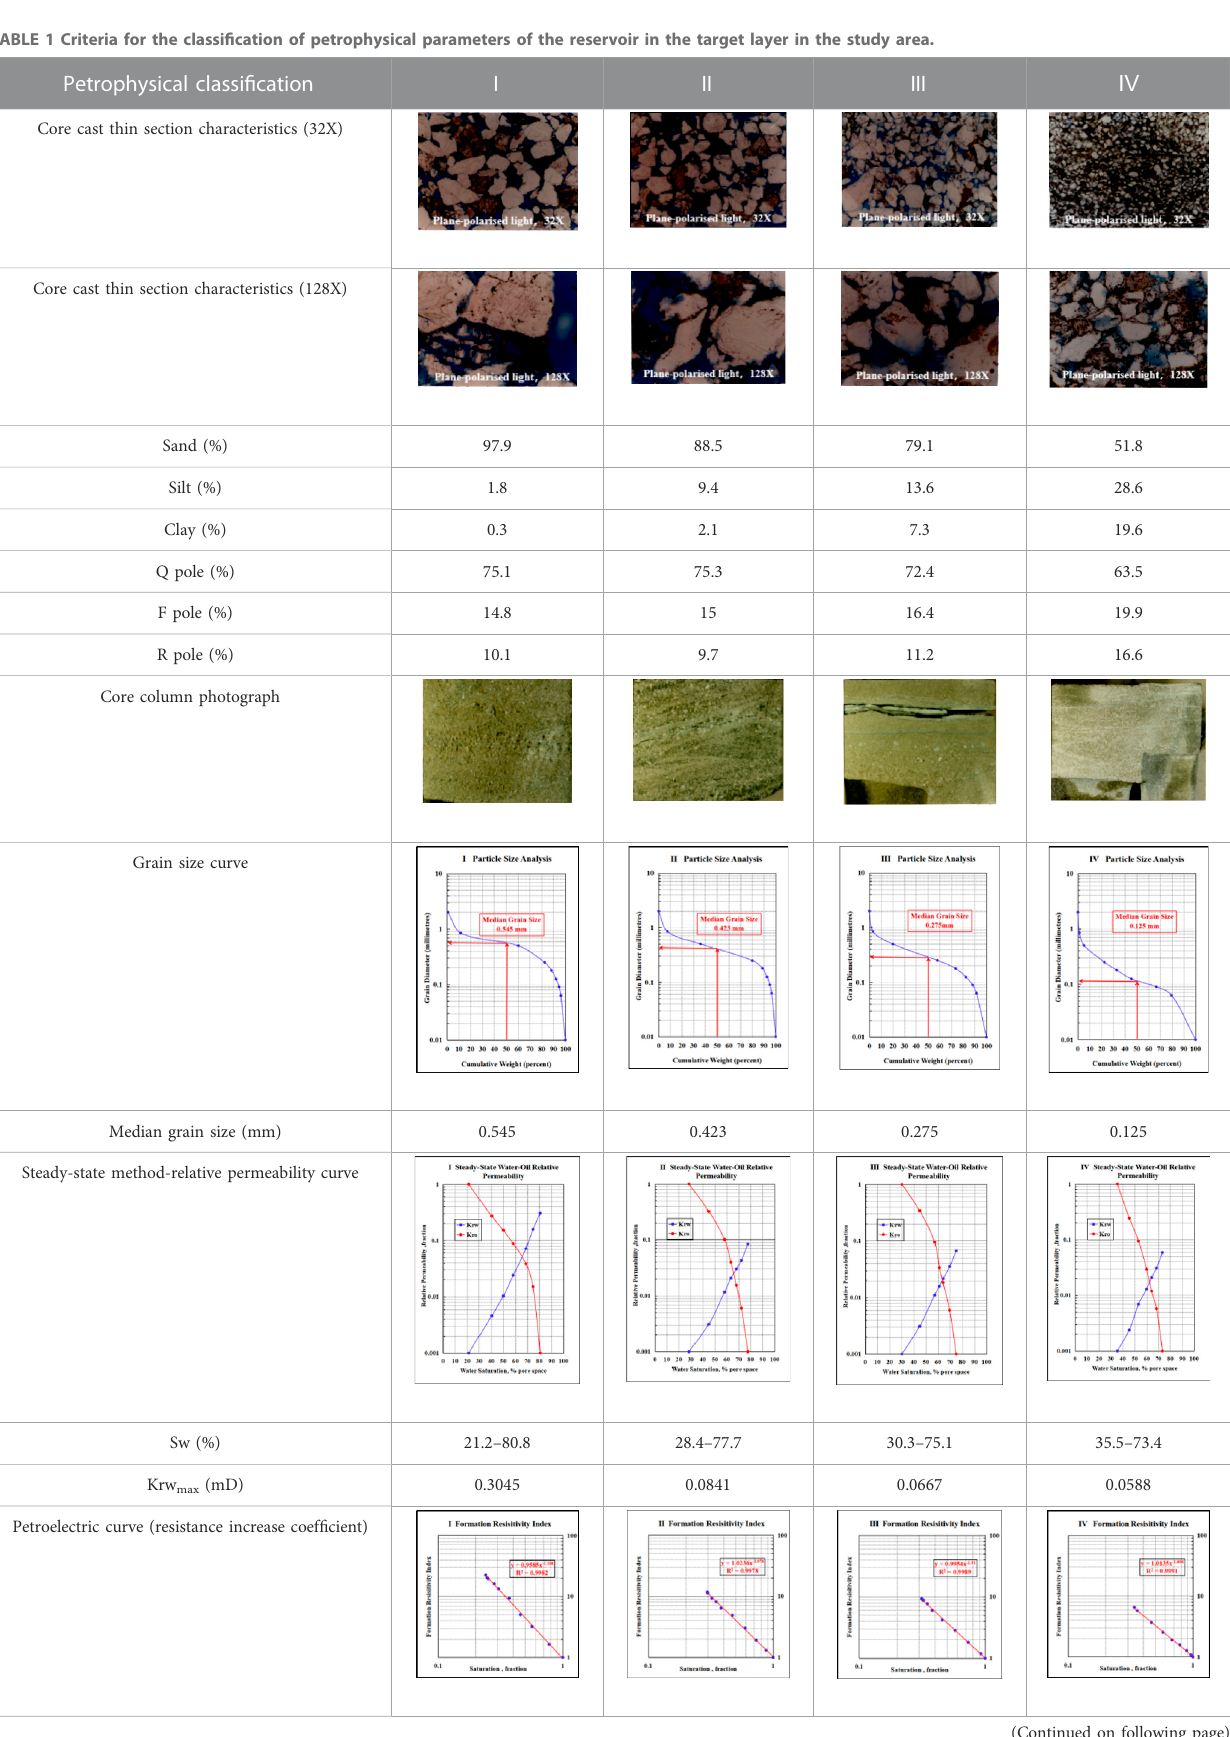
TABLE 1 Criteria for the classi fi cation of petrophysical parameters of the reservoir in the target layer in the study area. Petrophysical classi fi cation I II III